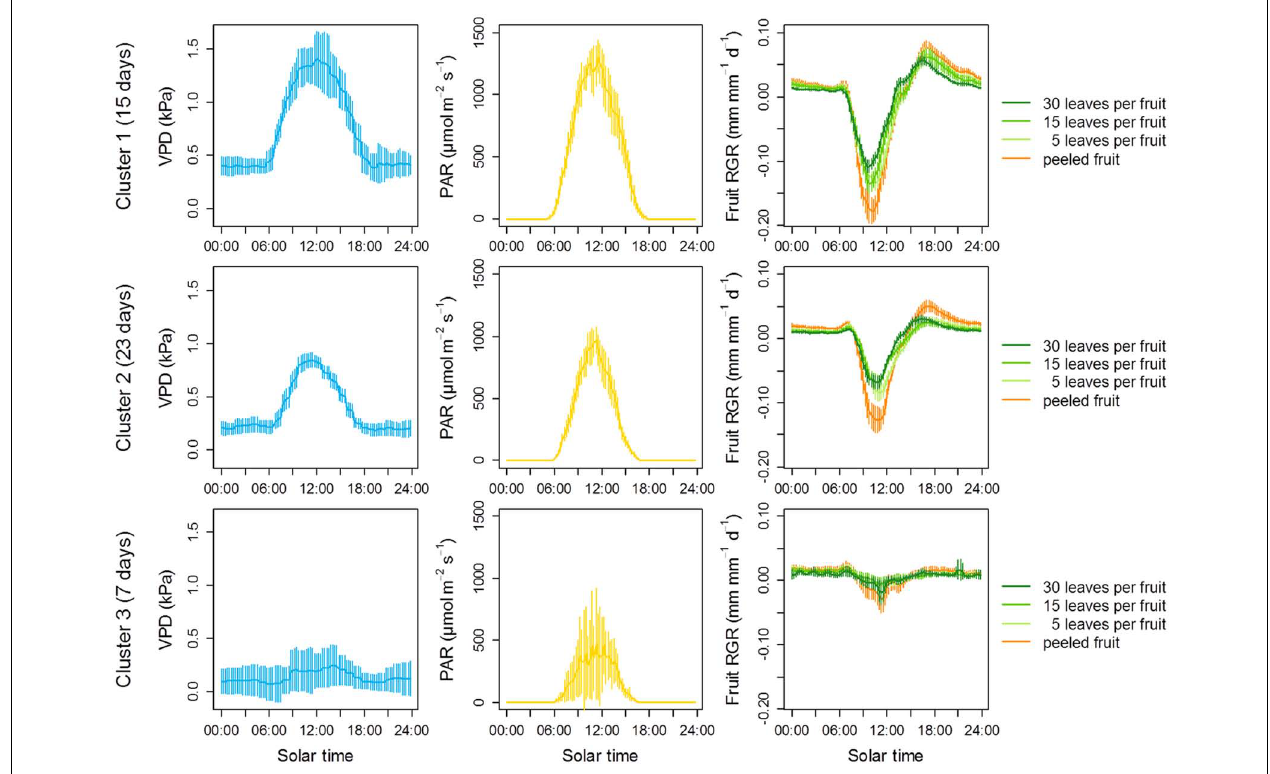
FIGURE 7 |The relationship between carbon availability and fruit growth is conditional on atmospheric water stress in clementine. Fruit growth was monitored using displacement transducers on at least three fruits per level of leaf-to-fruit ratio during 45 days between early September and late November. Some displacement transducers were also placed on peeled fruits from girdled fruiting branches with 30 leaves. Climate data (air humidity, temperature and irradiance) were